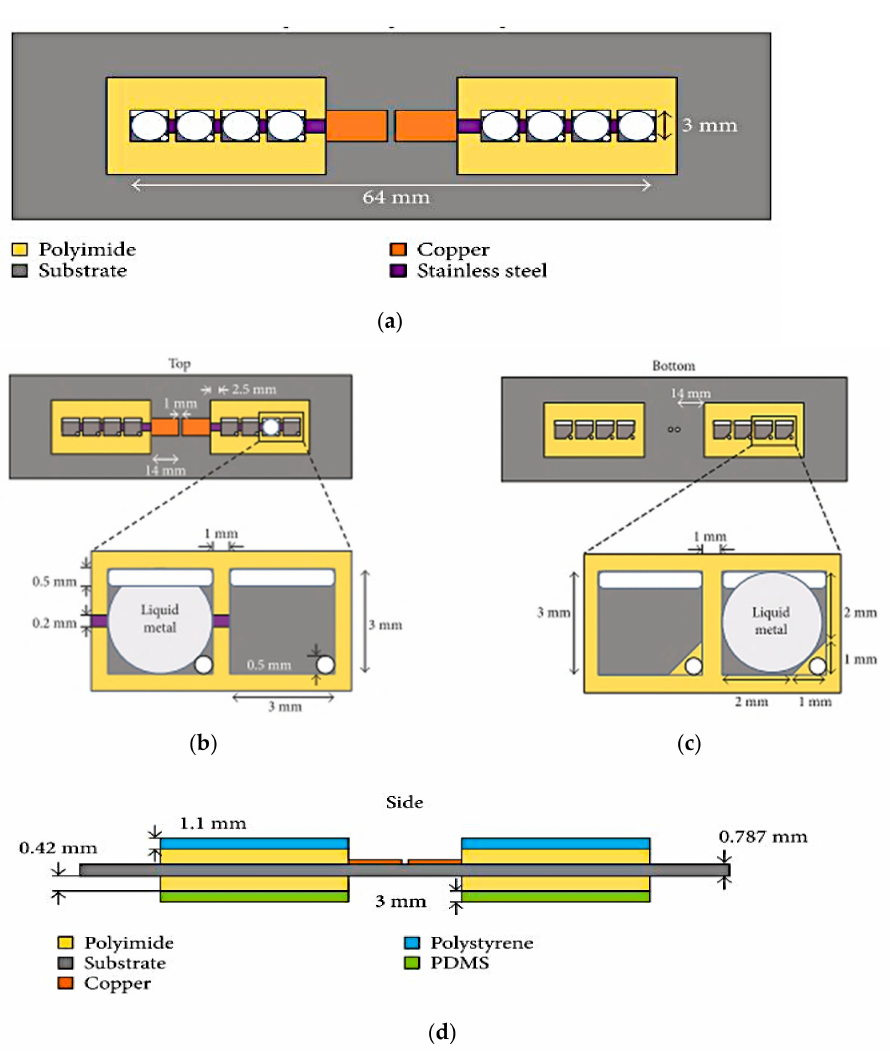
Figure 14. ( a ) The pixelated dipole antenna. ( b ) Top side pixel: ‘on’ state on the left side. ( c ) Bottom side pixel: ‘off’ state on the left side. ( d ) Side view